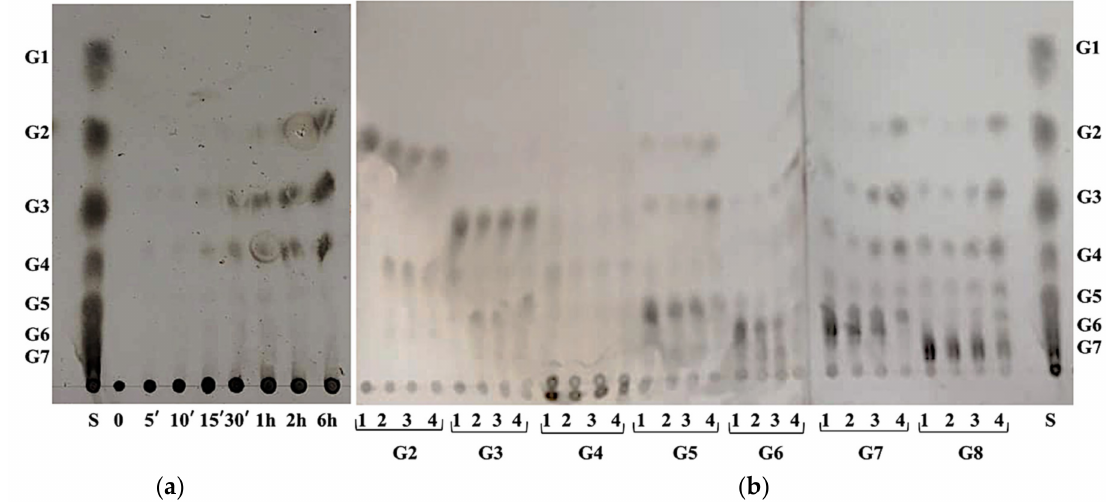
Figure 6. TLC analyses of BCA products from potato starch after 0, 5, 10, 15, 30 min, 1, 2 and 6 h of reaction ( a ) and various maltooligosaccharides (G2, G3, G4, G5, G6, G7 and G8) after 0 (1), 5 (2), 30 (3) and 60 min (4) ( b ). S: maltodextrins (G1 to G7). The reaction mixture contained 0.2 U of α -amylase activity and 1% substrate in 0.1 M Tris–HCl buffer (pH 7.5) was incubated at 50 ◦ C. The hydrolysis was stopped by heating at 100 ◦ C for 5 min. Approximately 5 µ L of each hydrolysate were spotted onto the TLC